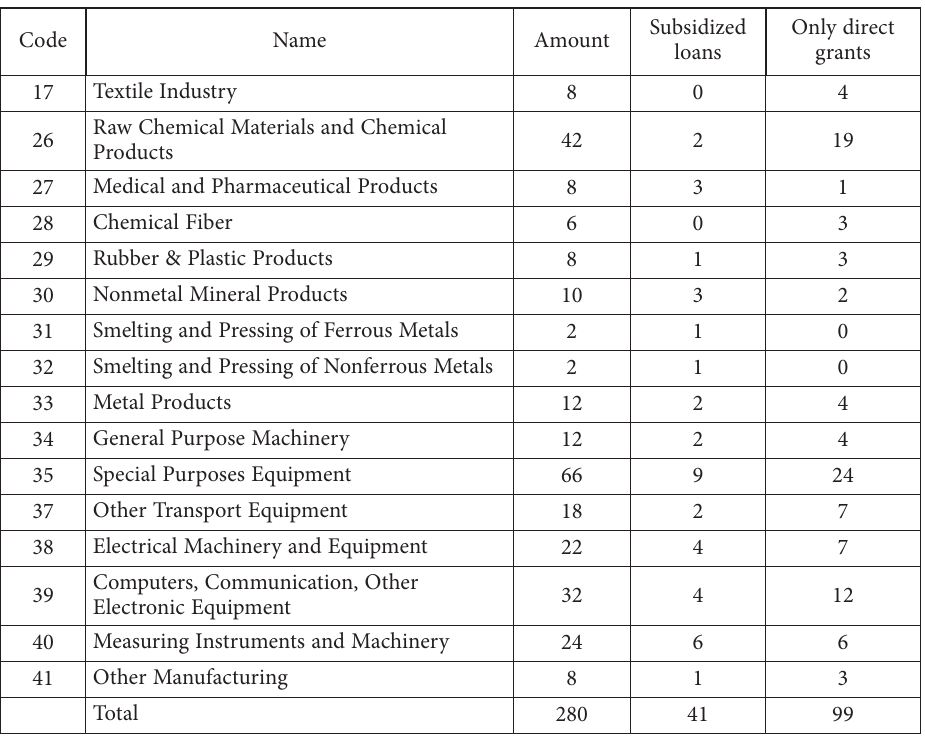
Table A.5. Industrial distributions based on the PSM samples